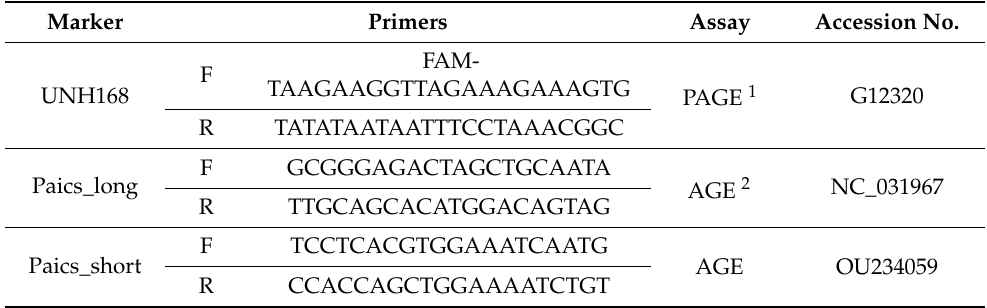
Table 1. Polymerase chain reaction (PCR) primers for amplicons used as genetic markers within genes at the critical region for sex determination on